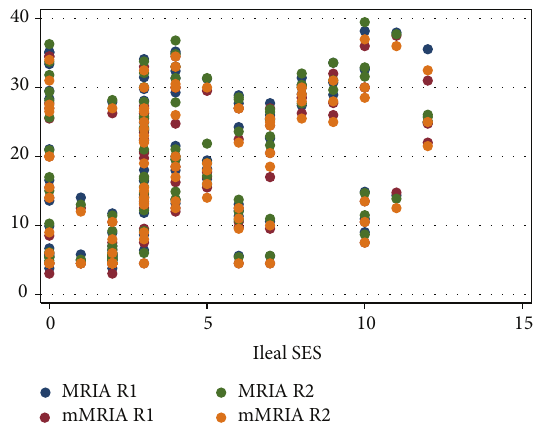
Figure 7: Scatter plot diagram of MRIA and mMRIA versus ileal SES values.